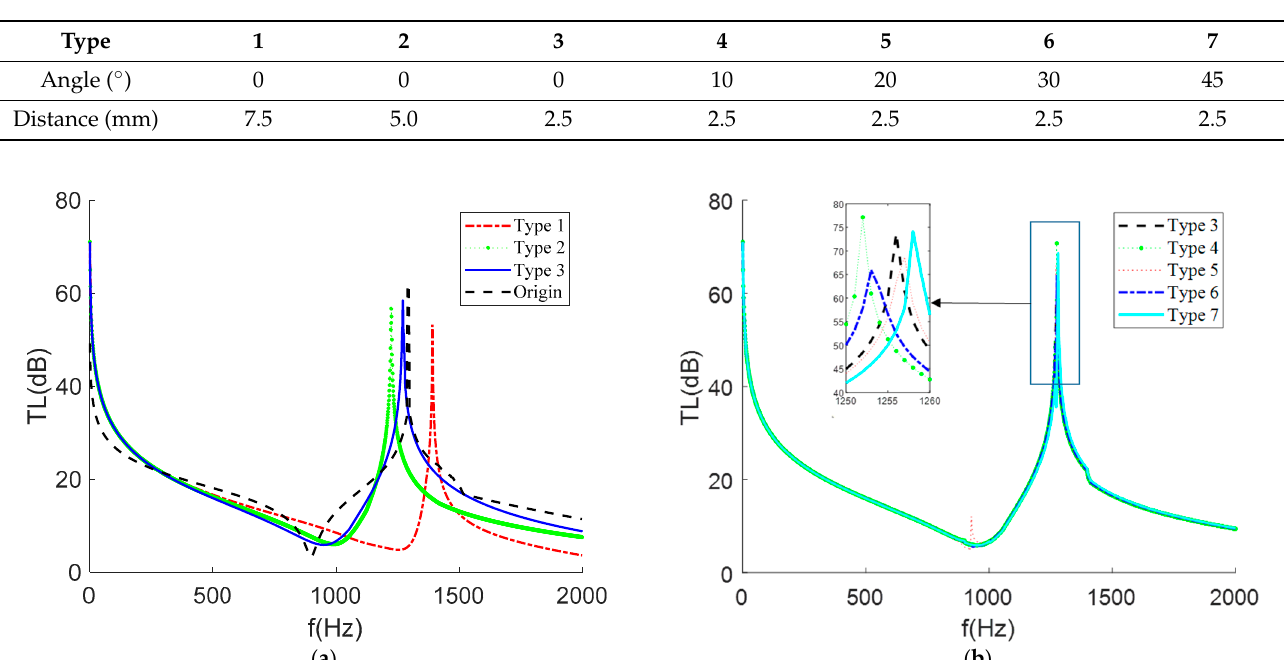
Figure 11. The STL when the masses were distributed in different positions of the film. ( a ) STL when the mass was distributed along the x-axis from the center of mass of the film. ( b ) Since the square film is a symmetrical figure, only the STL when the angle between the center of mass of the film and the mass was rotated from 0 to 45 ◦ was